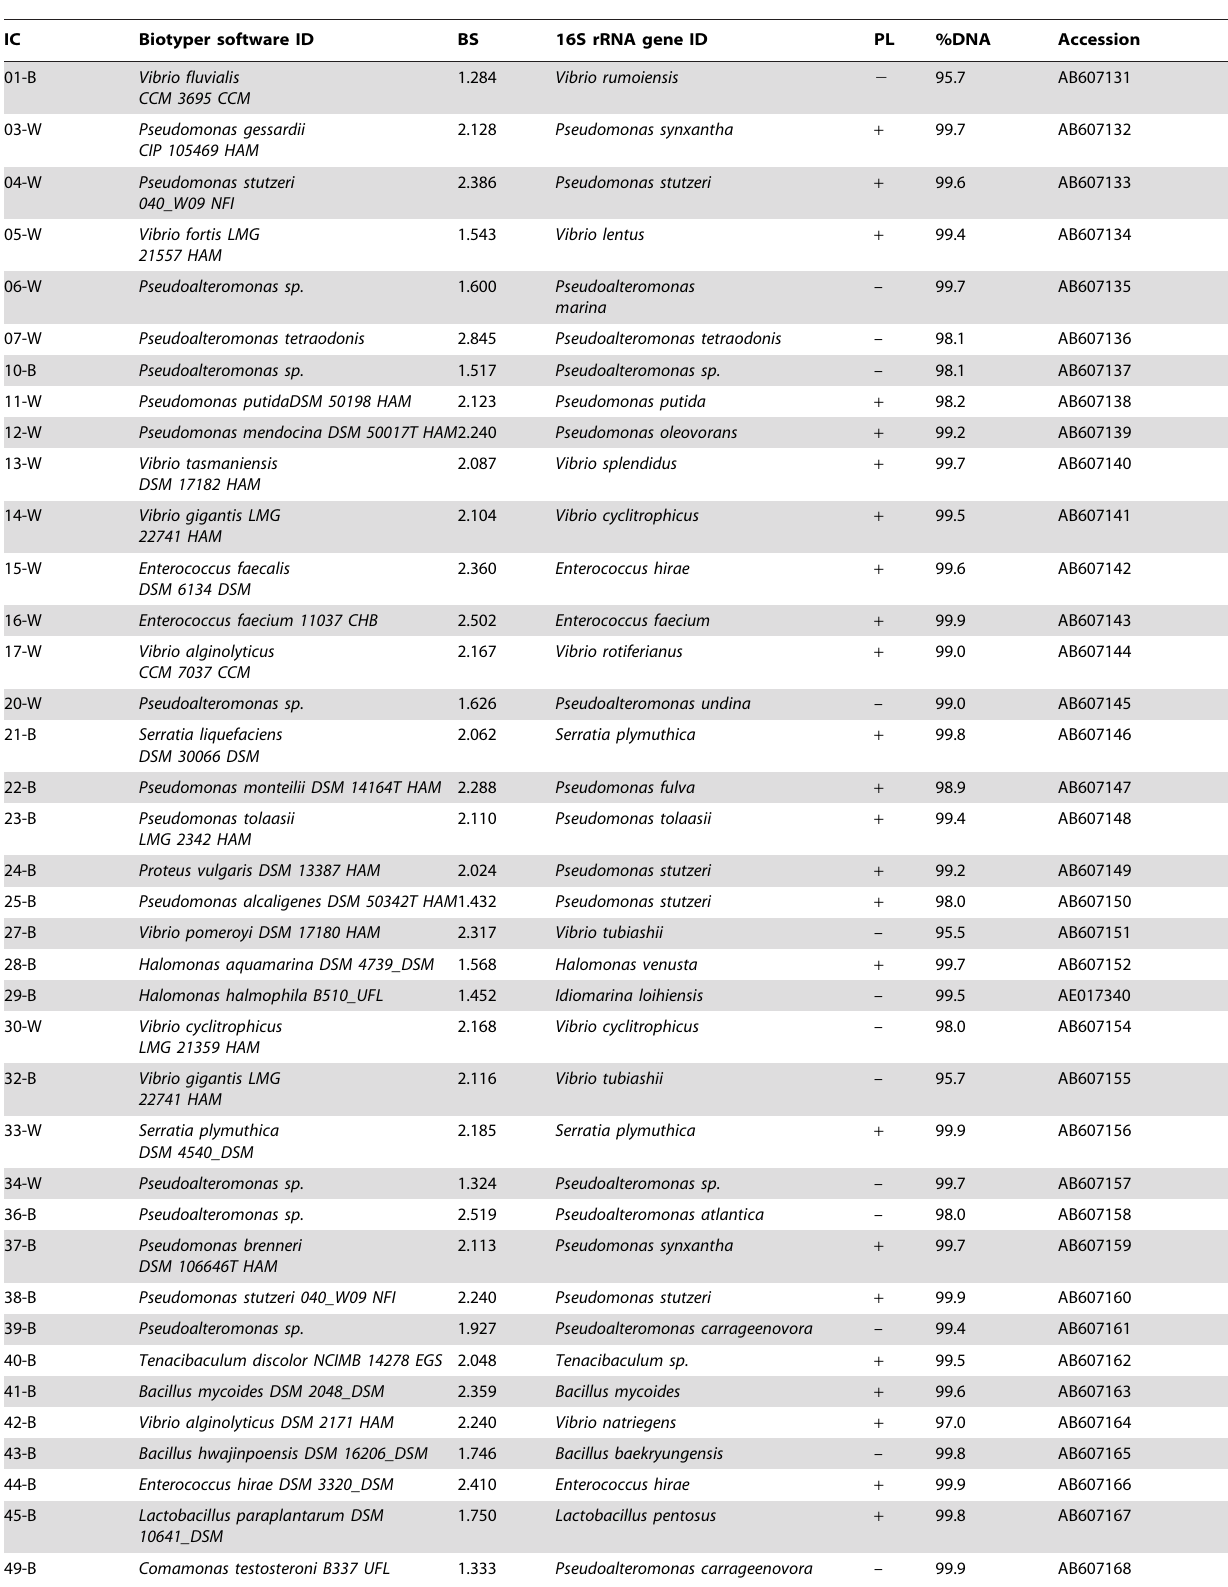
Table 1. Identification of marine bacteria from artificial ballast